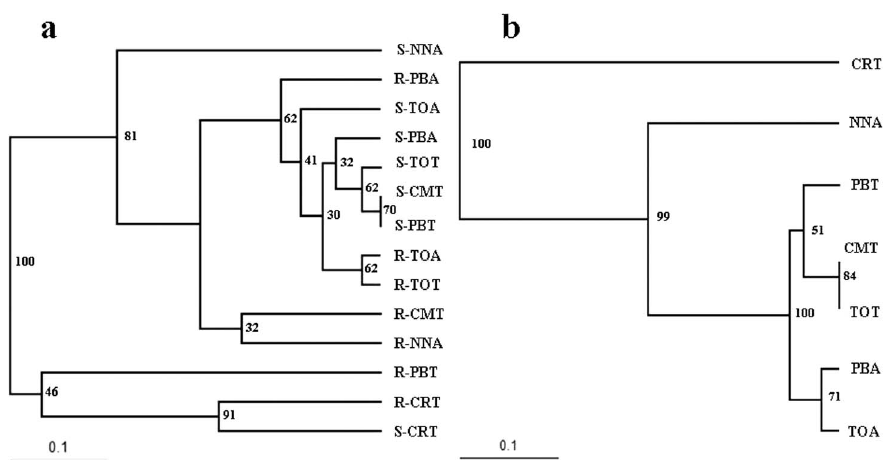
Figure 2. Cluster analysis of terminal restriction fragment length polymorphism patterns from AM fungal communities associated with Aquilariacrassna (A) and Tectonagrandis (T); a) TRFs patterns in roots (R-) and rhizosphere soils (S-) and b) TRFs patterns in five sites (CM: Chiang Mai, CR: Chiang Rai, NN: Nakhon-Nayok, PB: Phetchabun and TO: Thai Orchid Labs). The unweighted pair-group average (UPGMA) algorithm was used to cluster patterns based on Jaccard similarities. Percentage values based on 1000 bootstrap replicates are given at each node.